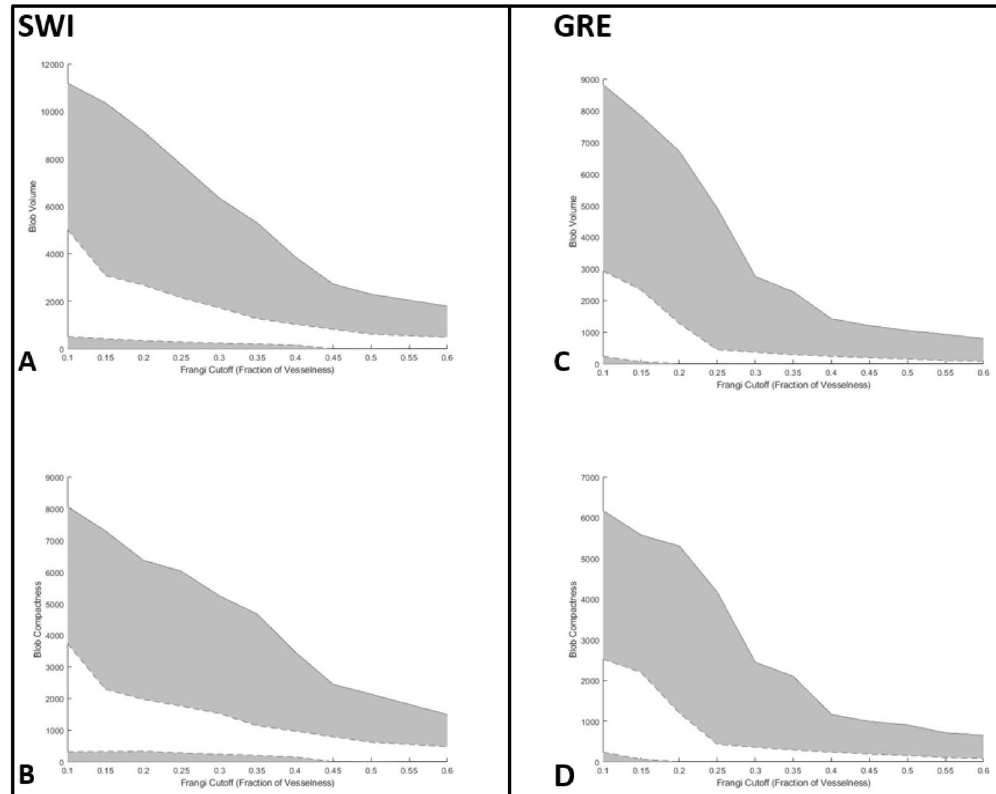
Figure 5. Illustration of Frangi-filter threshold effect on blob size and compactness. The dashed lines represent the bounds of the volumes of true positives, while the solid lines represent the bounds of the volumes of false positives. All false positives that fall within the shaded grey areas are removed. The purpose of trying a range of thresholds for vesselness was to determine the points of maximum difference (i.e., where the shaded area is largest, and therefore removes the most false positives). ( A) Range of volume of central blobs in Frangi-filtered ROIs on SWI images across different thresholds. ( B) Range of central blob compactness in Frangi-filtered ROIs on SWI images across different thresholds. ( C) Range of volume of central blobs in Frangi-filtered ROIs on GRE images across different thresholds. ( D) Range of compactness of central blobs in Frangi-filtered ROIs on GRE images across different